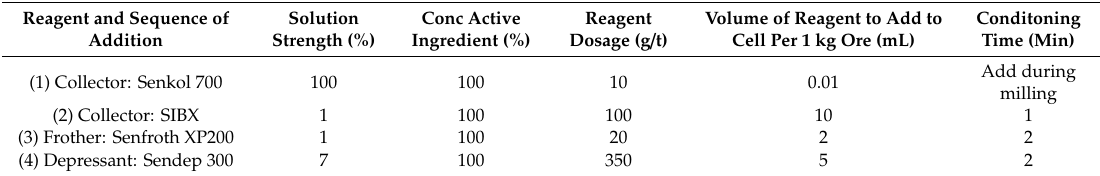
Table 2. Reagent suite used for the flotation test work including the sequence of addition, conditioning time and reagent